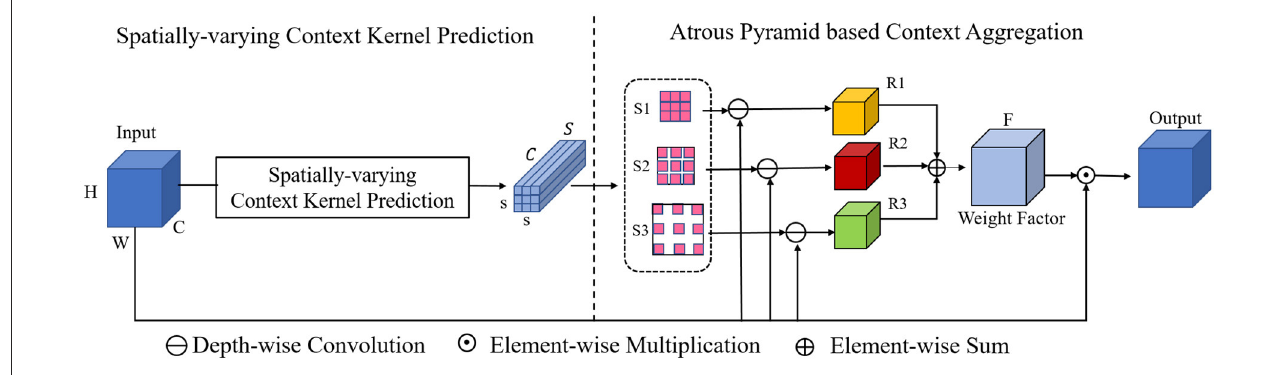
FIGURE3 Details of the proposed spatially-varying adaptive pyramid context aggregation module. The adaptive pyramid mechanism aggregates the contextual cues with multi-scale field-of-views via convolution pyramid with multiple atrous rates.